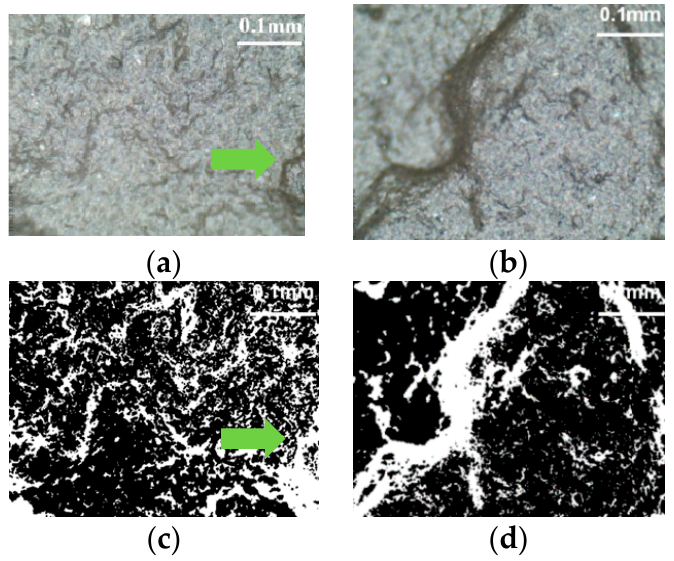
Figure 19. Effect of agitation on water distribution within the bed. ( a ) Before mixing (uniform